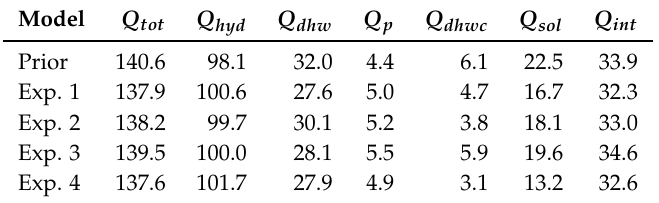
Table 2. Estimated specific thermal energy flows in kWh/ ( m 2 of the training period multiplied by 8 760 h (thus not representative for a typical